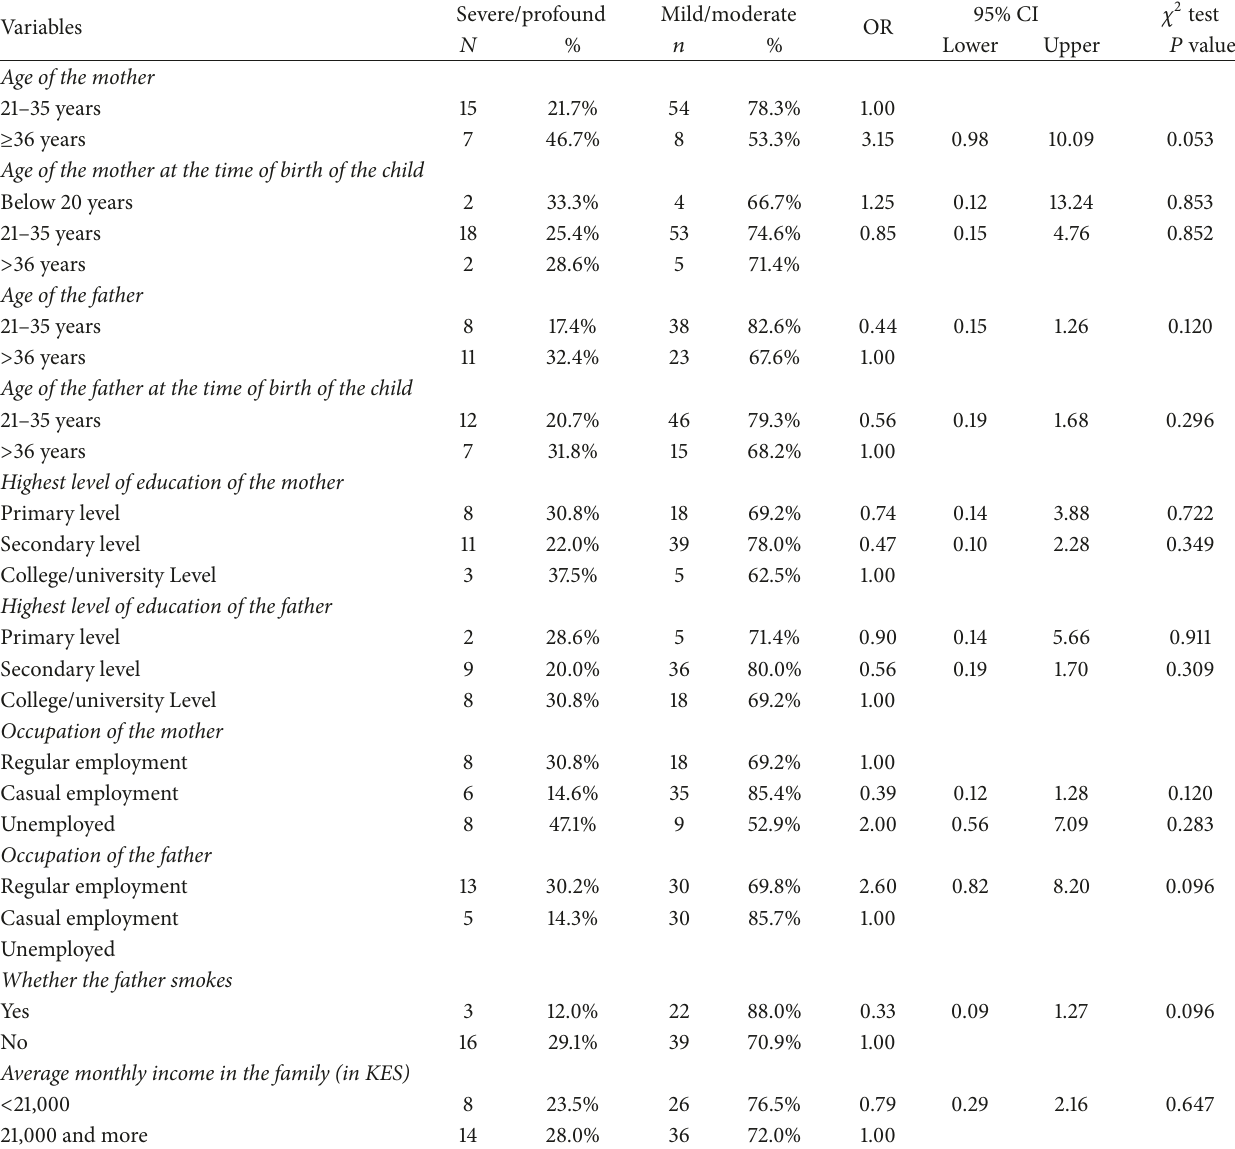
Table 4: Association between sociodemographic and economic characteristics of mothers and severity of intellectual disability.